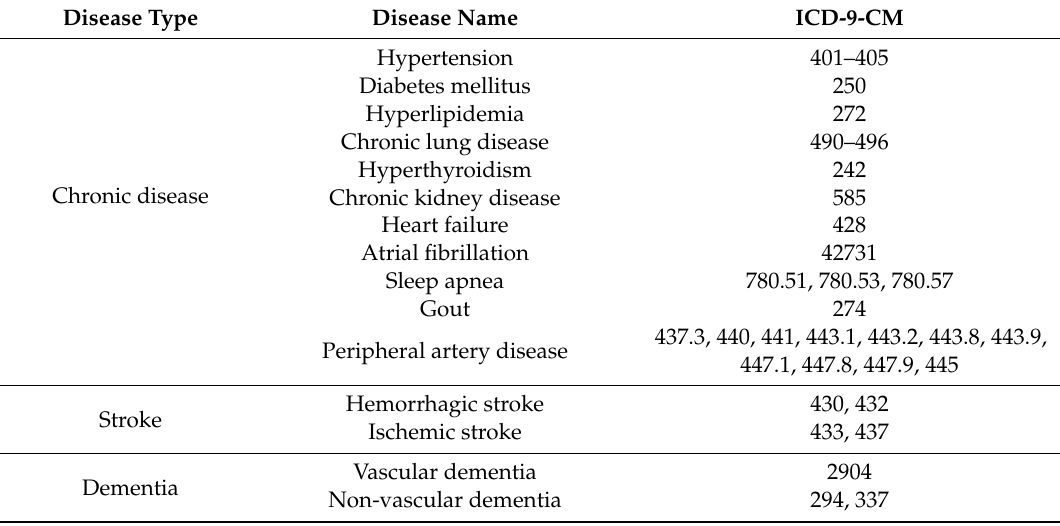
Table 1. ICD-9-CM code definition of all